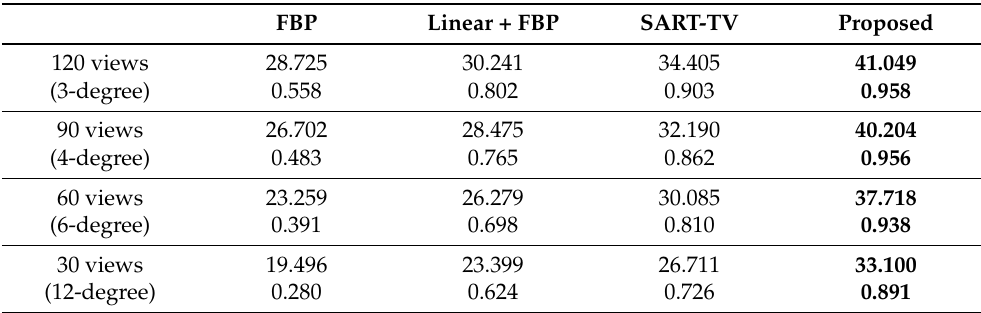
Table 1. Average PSNR and SSIM results of the traditional and proposed methods at different angular